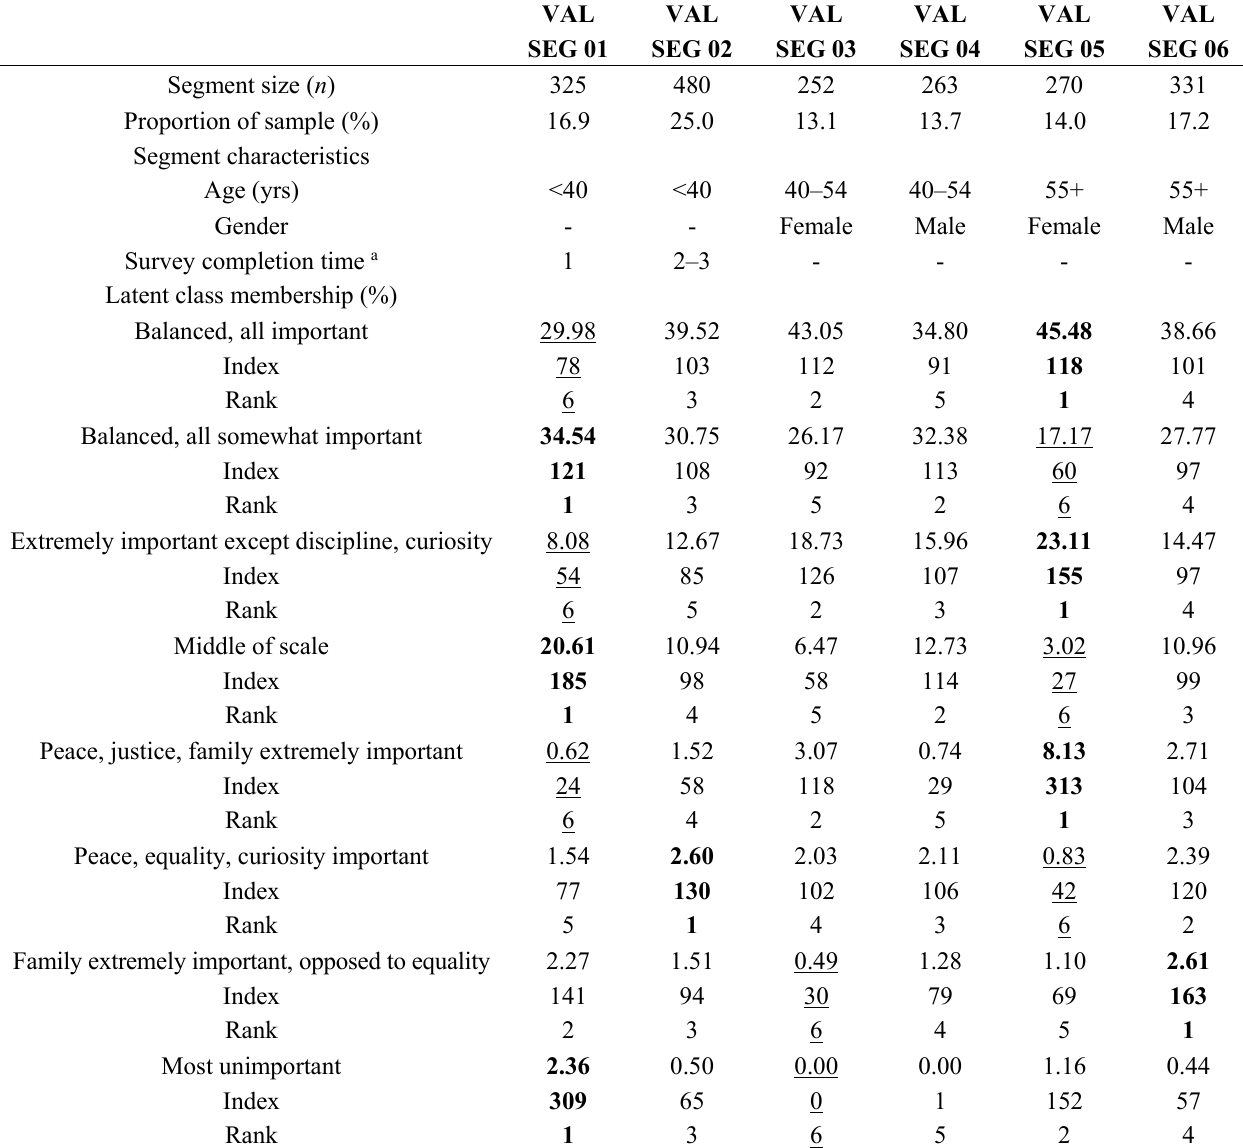
Table 2. Summary of segmentation of value-based latent class